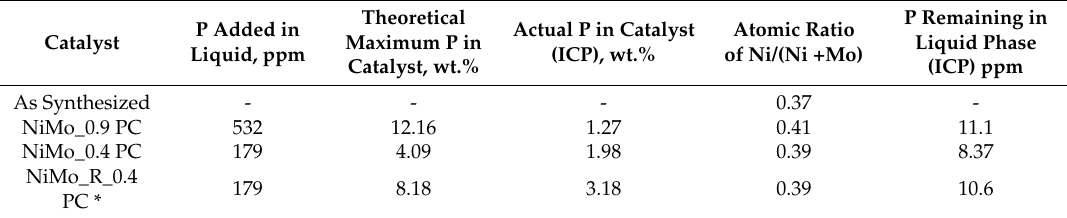
Table 4. ICP-SFMS data for spent catalyst and liquid